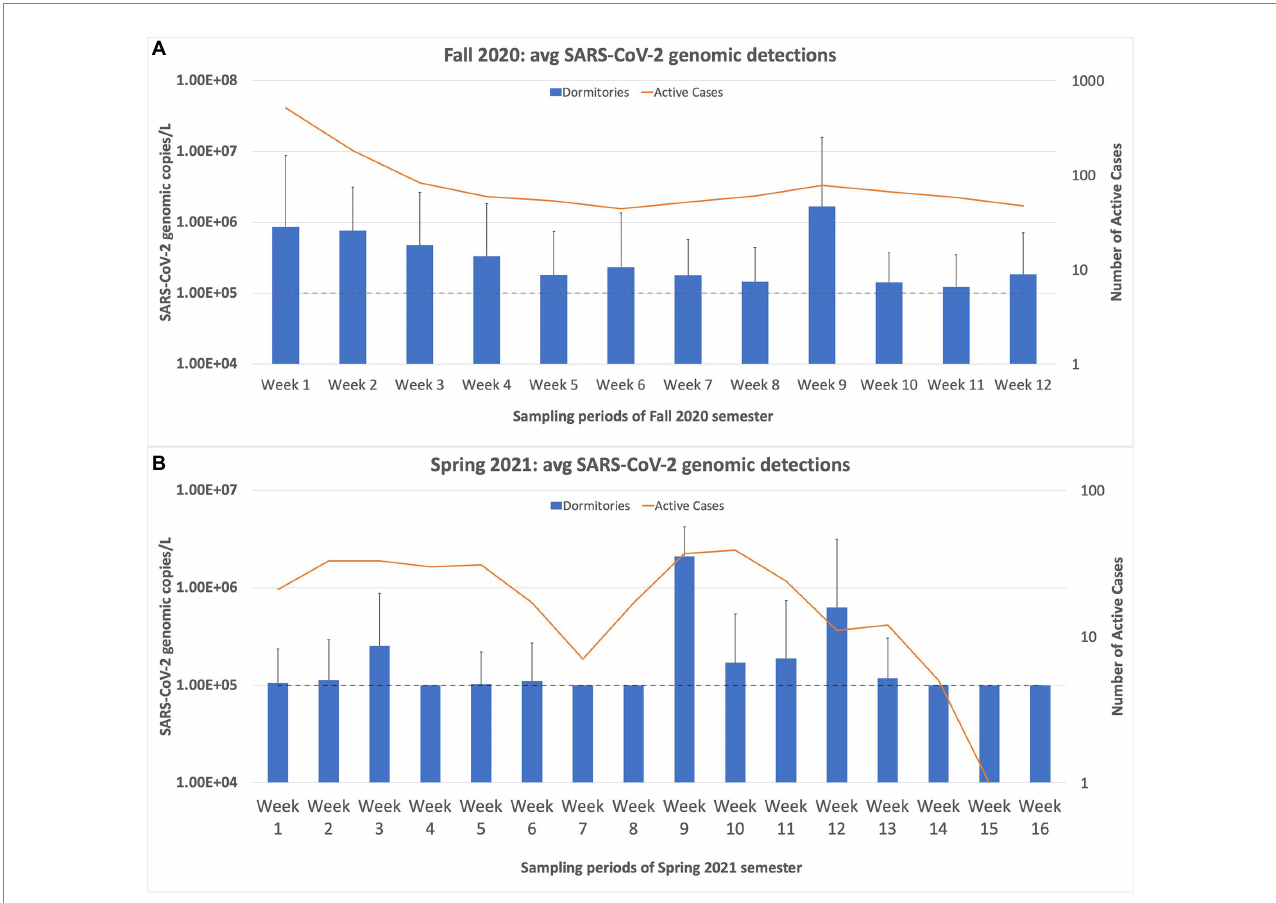
FIGURE 4 Weekly sampling results for the university dormitories plotted against the active cases in the dormitories, as reported by the student health center on campus. (A) displays the sampling results for the Fall 2020 semester, and (B) displays the results for the Spring semester of 2021. The dashed line in both charts represents the limit of quantification for the N1 RT-qPCR assay. Any positive samples deemed “below quantifiable levels” are listed at 10 copies/ μ L. The error bars represent the maximum range of the positive sample concentrations above the average. Spearman’s rank correlation was computed to determine the relationship between the average SARS-CoV-2 copies/L detected in the wastewater samples of the dormitories and the active cases reported by the Student Health Center. There was a moderately positive correlation between the two variables, r (25) = [0.653], p =